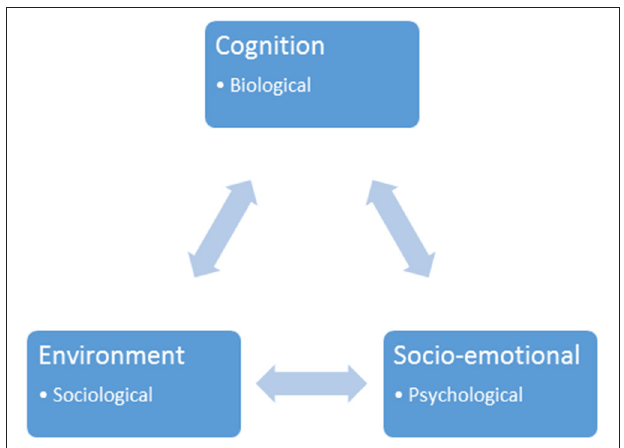
FIGURE 4 | Cognition, socio-emotional, and environmental approaches combined with the Bio-Psycho-Social